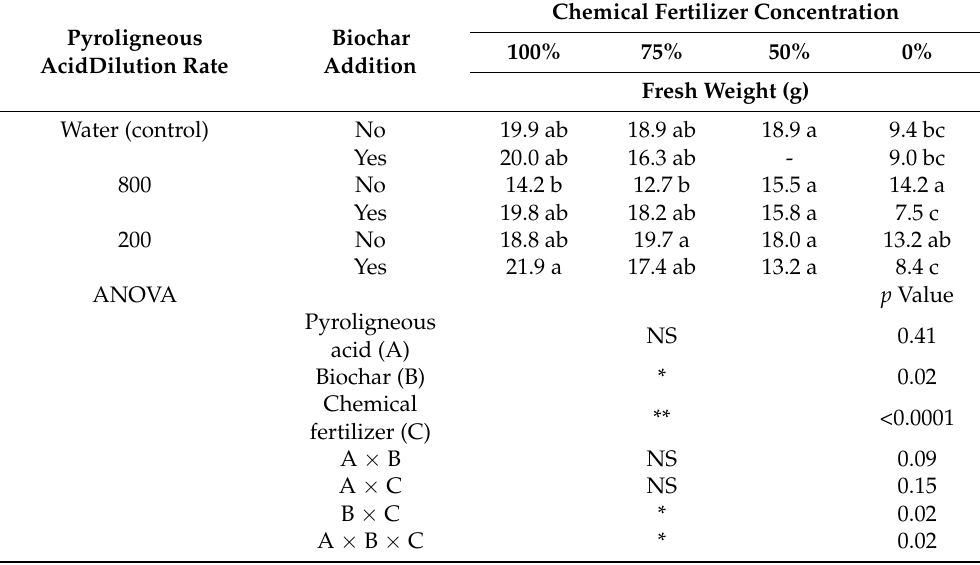
Table 4. The effect of pyroligneous acid (PA) and biochar on fresh weight of Komatsuna ( Brassica rapa var. perviridis ). Values represent the means of three replicates. × 800 and × 200 represent PA dilution rates: 1 part PA, and either 800 or 200 parts water. Different lowercase letters indicate significant difference at p < 0.05 as indicated by Tukey’s tests. NS: not significant, **: p -value < 0.01, *: p -value <